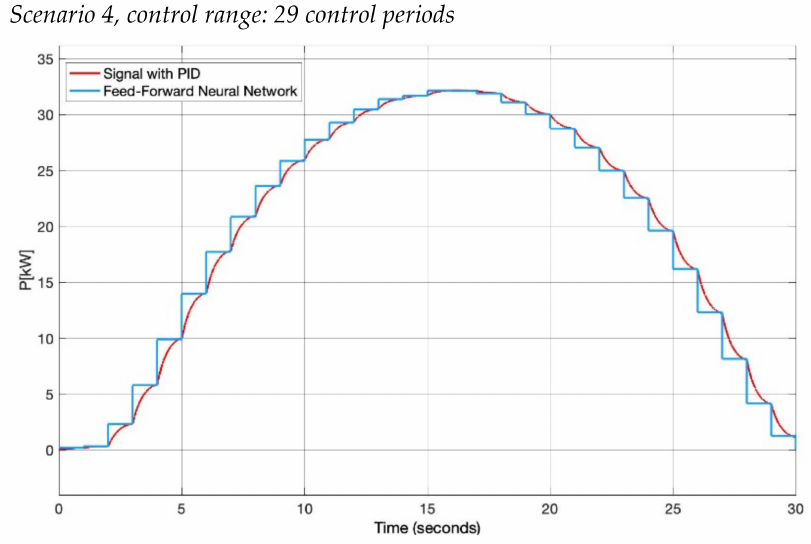
Figure 36. Control signal for BESS 2, p.f. = 0.95,